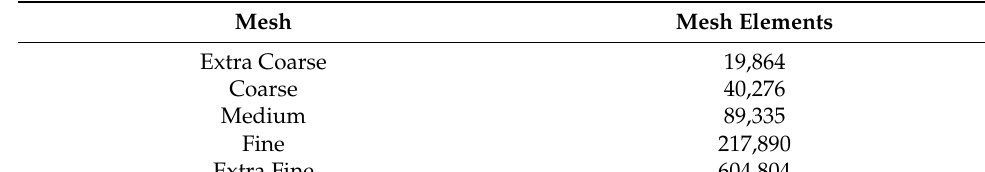
Table 1. Information regarding the five grids used for the GCS.